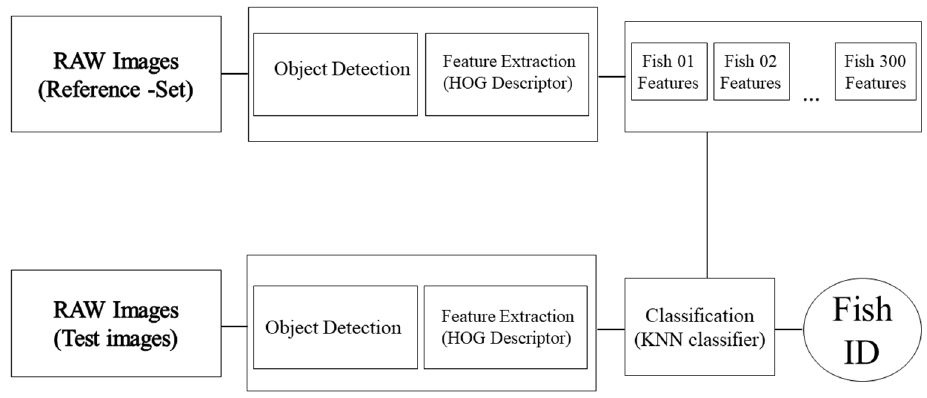
Figure 3. Identification